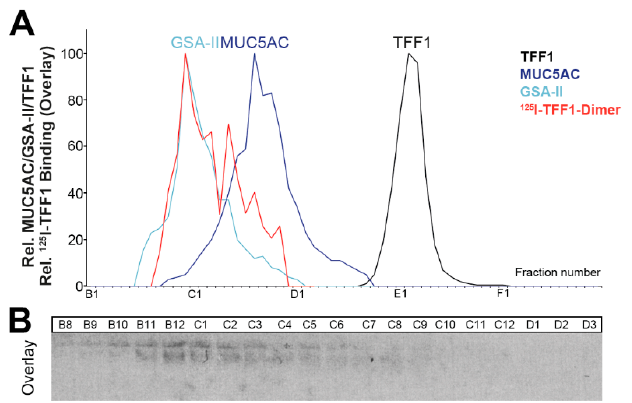
Figure 6. Analysis of a human gastric corpus E1-extract (M C -577) after reduction in boiling 1% β -mercaptoethanol and binding study with synthetic 125 I-labeled synthetic human TFF1 homodimer. ( A ) Distribution of MUC5AC (dark blue), MUC6 (lectin GSA-II; light blue), and TFF1 (black) after SEC on a Sephacryl S-500 HR column. The distribution of MUC5AC and MUC6 on this column has been reported previously [43]. Furthermore, the relative intensity of the hybridization signals (autoradiography and semi-quantitative analysis) obtained after incubating the blot with 125 I-TFF1 homodimer (overlay assay) is shown in red. ( B ) 1% AgGE and subsequent Western blot analysis of the fractions B8-D3. Shown are the hybridization signals (autoradiography) obtained after incubating the blot with 125 I-TFF1 homodimer (overlay assay).